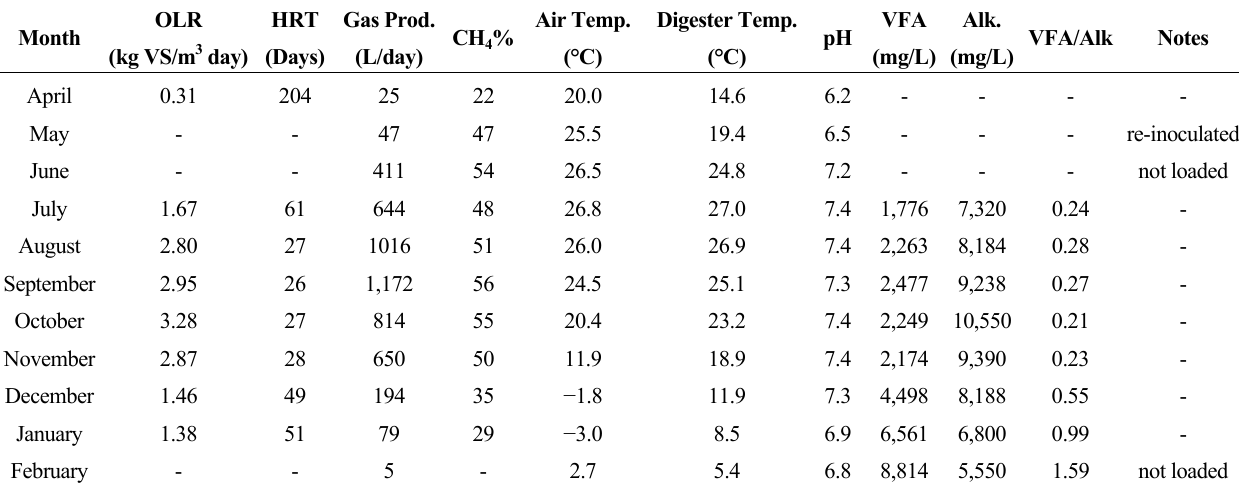
Table 1. Monthly averages of digester performance data beginning in April